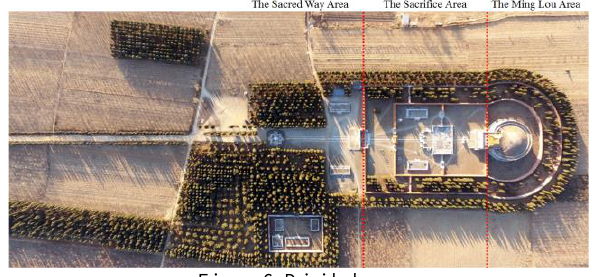
Figure 6. Divided area